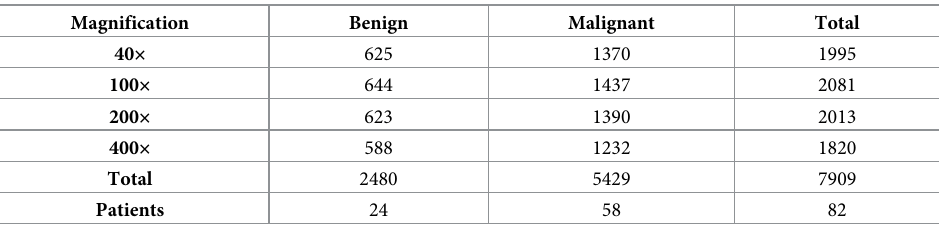
Table 1. Image distribution by magnification factor and